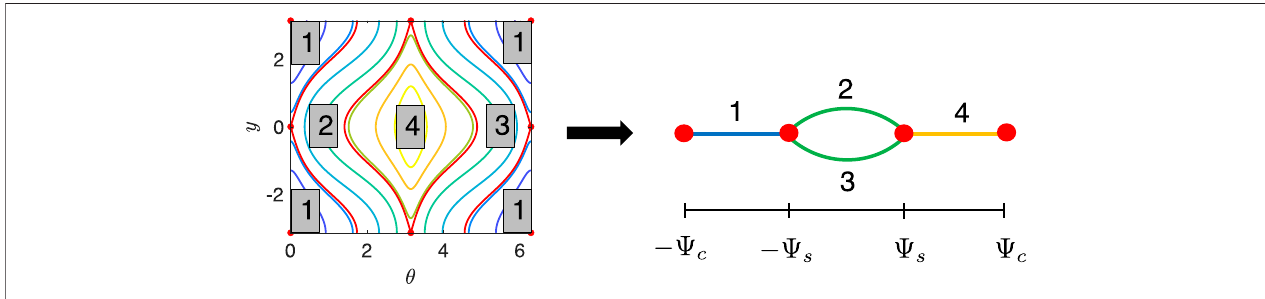
FIGURE 8 | Reduction of the swimmer phase space to a graph. Each edge of the graph corresponds to the labeled region of phase space, and the nodes correspond to fi xed points and separatrices at the boundaries of each region. Ψ is a coordinate along the edges of the graph.